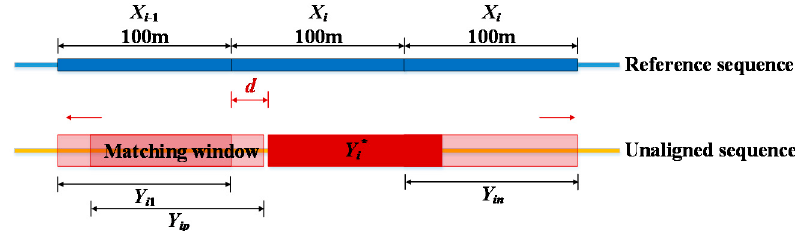
Figure 4. Correlation-based initial alignment algorithm.